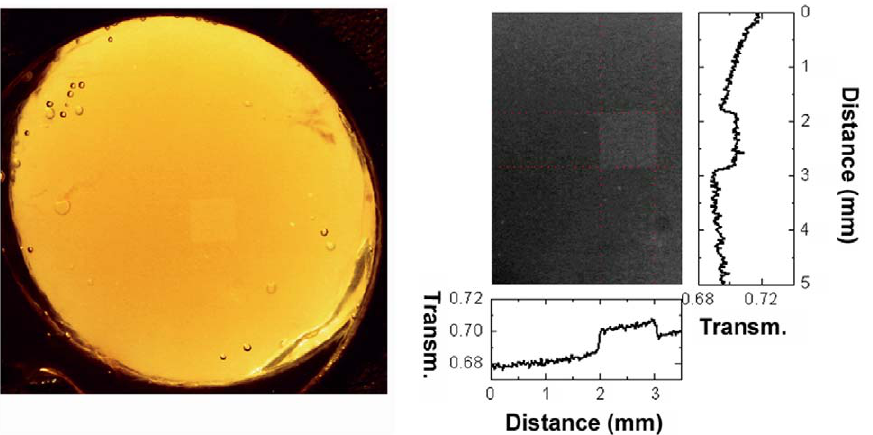
Figure 1. Photographic documentation of the laser photobleaching. To the right is shown a color photograph of a 58 year old donor lens after treatment and to the left is shown a black-and-white excerpt of the same photograph with an image analysis of the light intensity in the photograph. The treated area is seen as a lighter square and it is marked by red dotted lines on the black and white photograph. The relative transmission was calculated by using the black plastic spacer surrounding the lens as a reference for 0% transmission and the vacant space between the lens and the plastic spacer as a reference for 100% transmission.